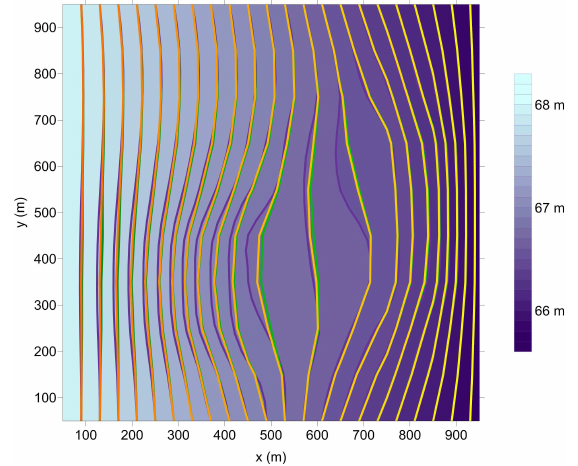
Figure 8. Simple test of the CMM: image plot of the reference hydraulic head and contour lines of the reference h field (purple) and of the h fields obtained for the K fields estimated with the CMM: yellow lines refer to the K field obtained with the integral approach (central map of Figure 7) and green lines to the K field obtained with the differential approach (right map of Figure